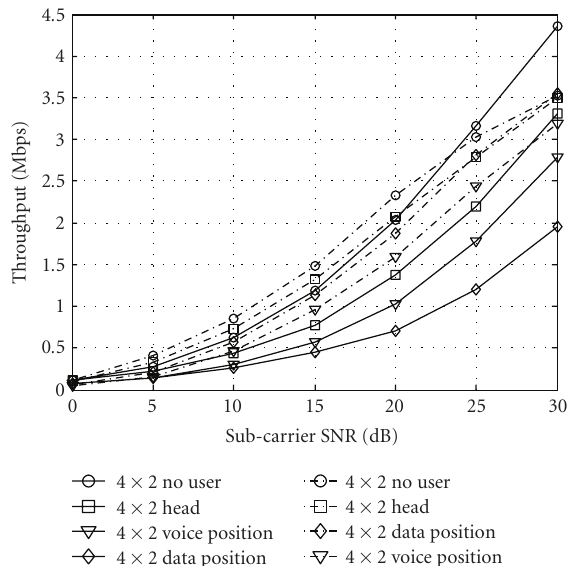
Figure 14: Link throughput in di ff erent usage scenarios for an M × N MIMO system with transmit diversity.